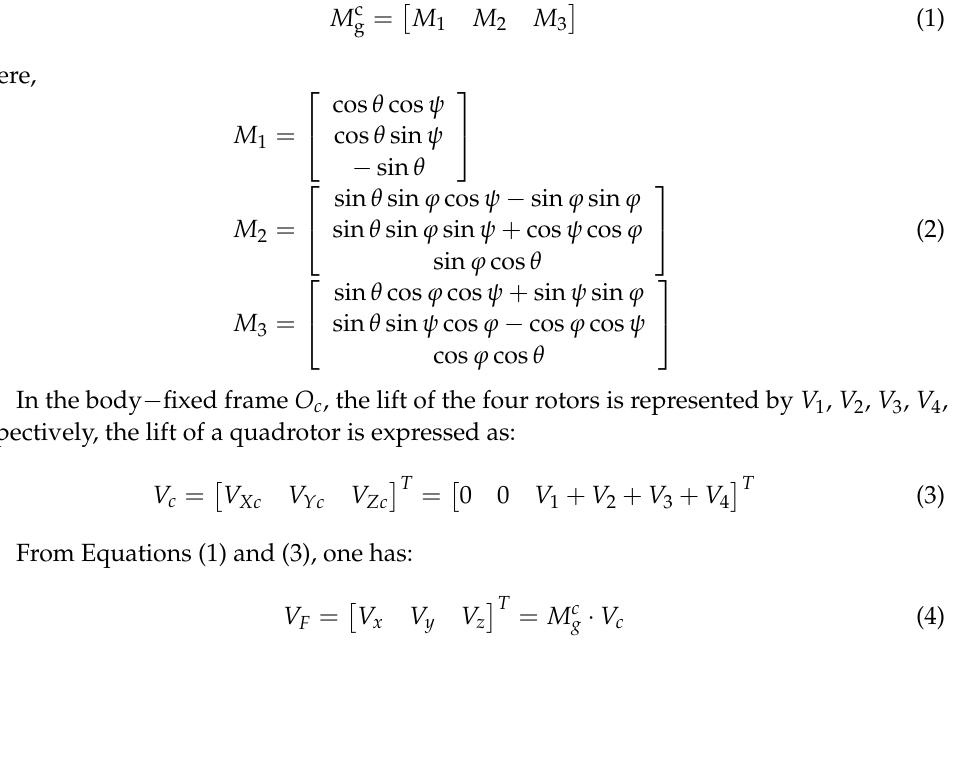
O , respectively, introducing c